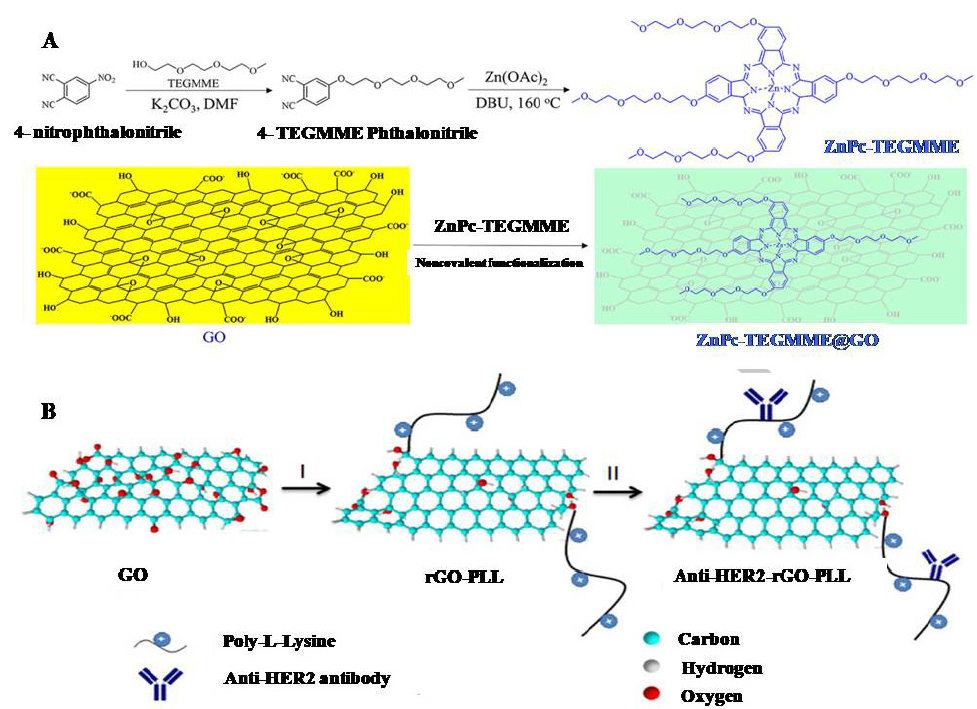
Figure 4. ( A ) Schematic Illustration of the Preparation of ZnPc-TEGMME@GO [76]. ( B ) Synthesis of anti-HER2-rGO-PLL is performed in two steps: (I) GO is functionalized with PLL under